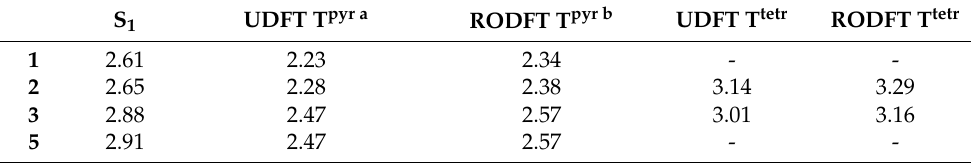
Table 3. DFT/TDDFT calculated energies of different electronic states, relative to the S 0 in